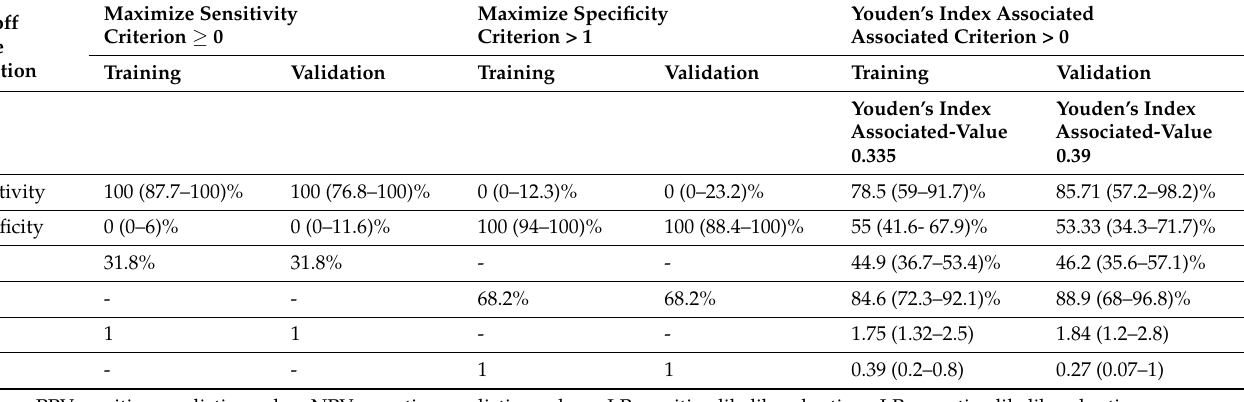
Table A3. The points of ROC curve model for cut-off 13.80 of E/e’ ratio according to rehospitalization for a first episode of acute HfpEF within the first 6 months after the first admission, for both the training cohort and the validation contingent. Cut-off